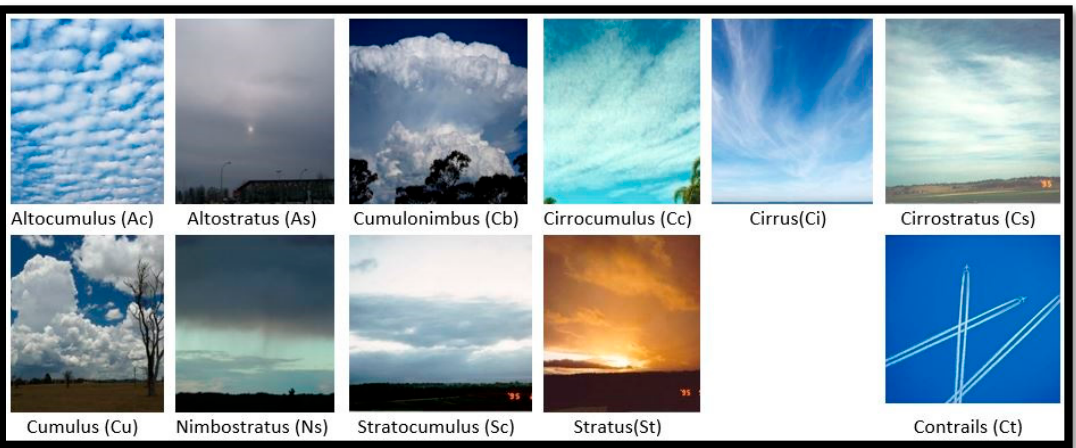
Figure 4. Cloud samples of the CCSN dataset.